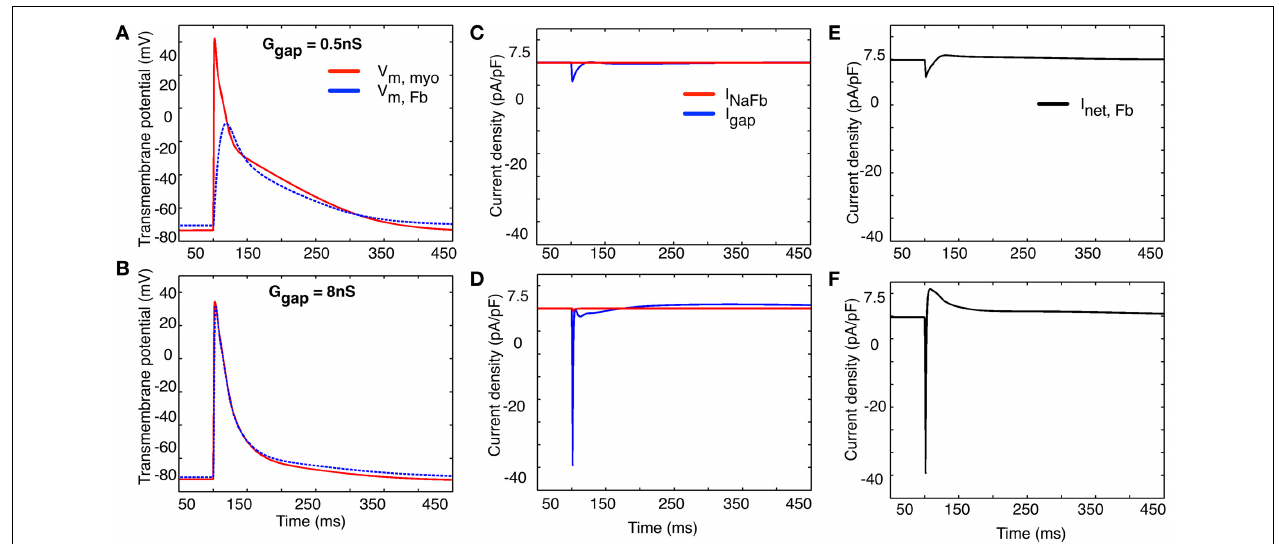
FIGURE 9 | Illustration of two selected values of the effects of coupling resistance on the electrotonic membrane potential (panels A,B), “gap current” and current flow between the two cell populations (1 myocyte: